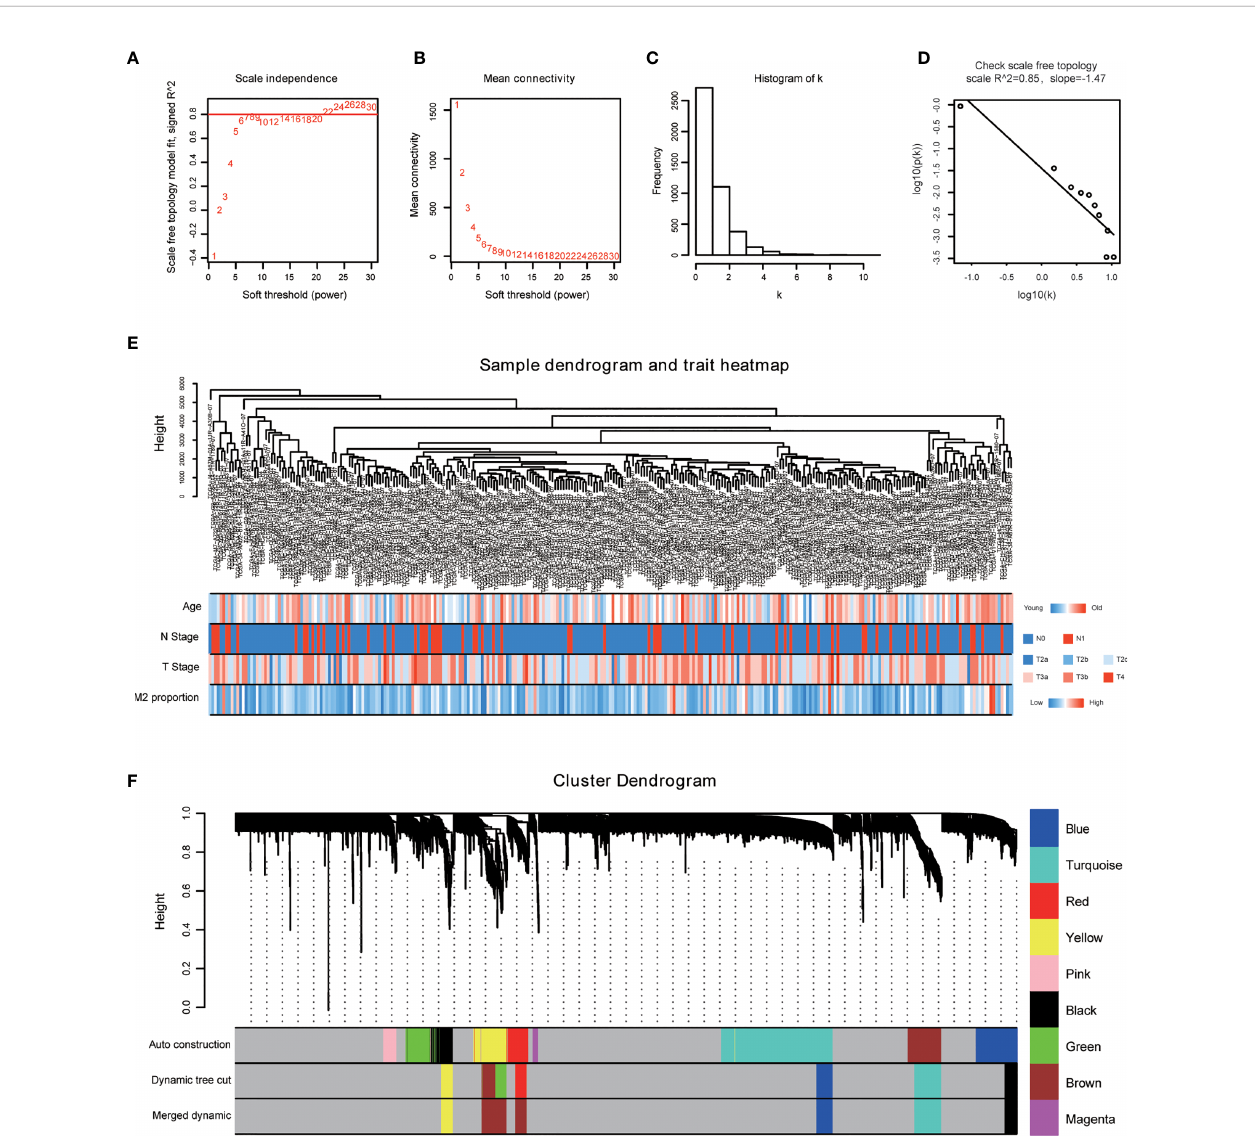
FIGURE 3 | WGCNA was performed based on PCa samples from TCGA database. (A) Analysis of the scale-free fi t index for various soft-thresholding powers; (B) Analysis of the mean connectivity for various soft-thresholding powers; (C) Histogram of connectivity distribution when b = 22; (D) Checking the scale free topology when b = 22; (E) The sample dendrogram and corresponding clinical characteristics; red: high, blue: low. (F) Cluster dendrogram of 292 samples with eligible